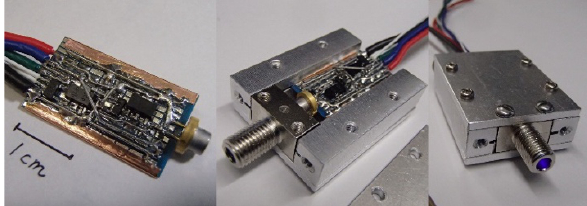
Fig. 4. Pictures of the pulsed laser. The pulse shaping circuit and the laser diode are contained in a small aluminum box, which also provides for thermal conduction. The aluminum box is designed to connect to an optical